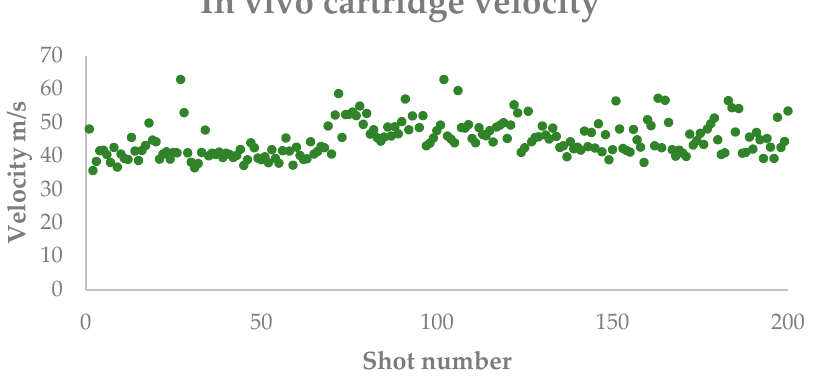
Figure 15. In vivo velocity measurements for 200 cattle shot with green 4.50 grain cartridges in an Accles and Shevoke ‘Cowpuncher’ penetrating captive bolt device fitted with the experimental velocimeter.